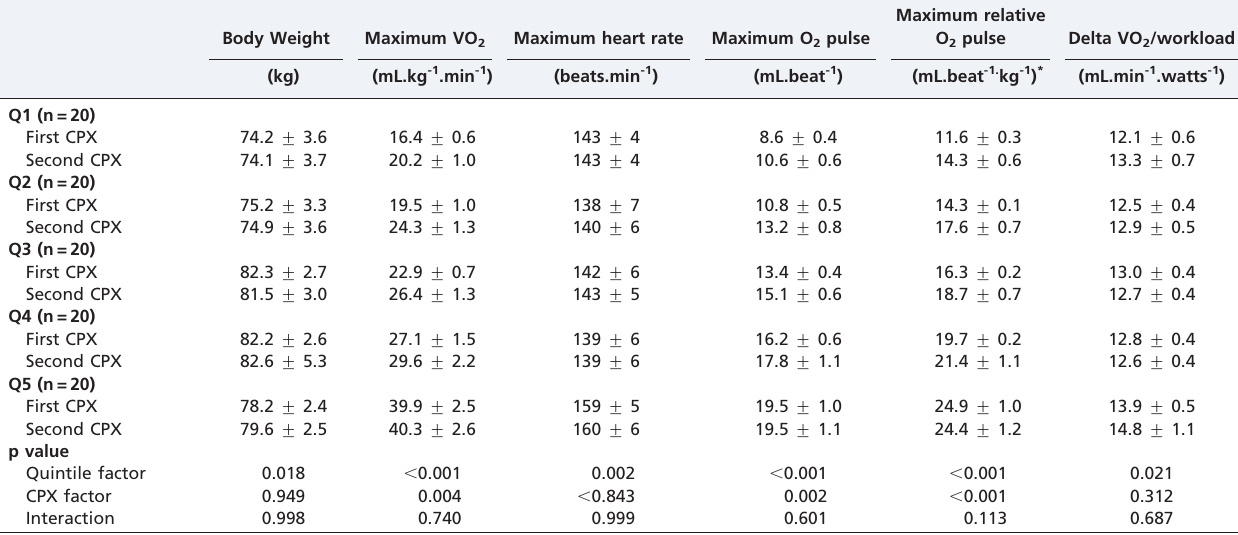
Table 3 - Cardiopulmonary exercise testing results by quintiles of maximum relative O 2 pulse.